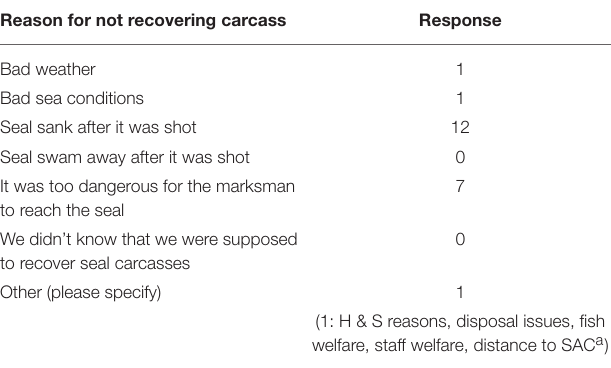
TABLE 9 | Responses to Question 10 of License Holder Survey.